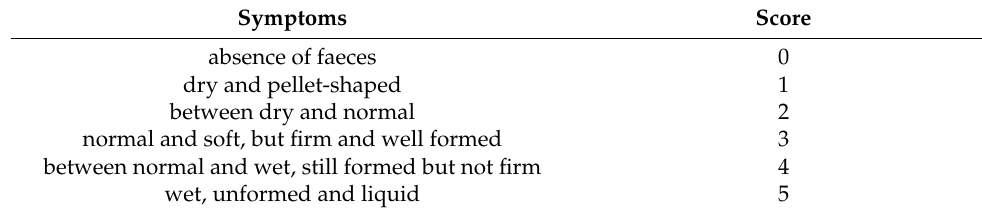
Table 4. Scoring system for sows’ faeces according to Oliviero et al. [17]. Symptoms Score absence of faeces 0 dry and pellet-shaped 1 between dry and normal 2 normal and soft, but firm and well formed 3 between normal and wet, still formed but not firm 4 wet, unformed and liquid